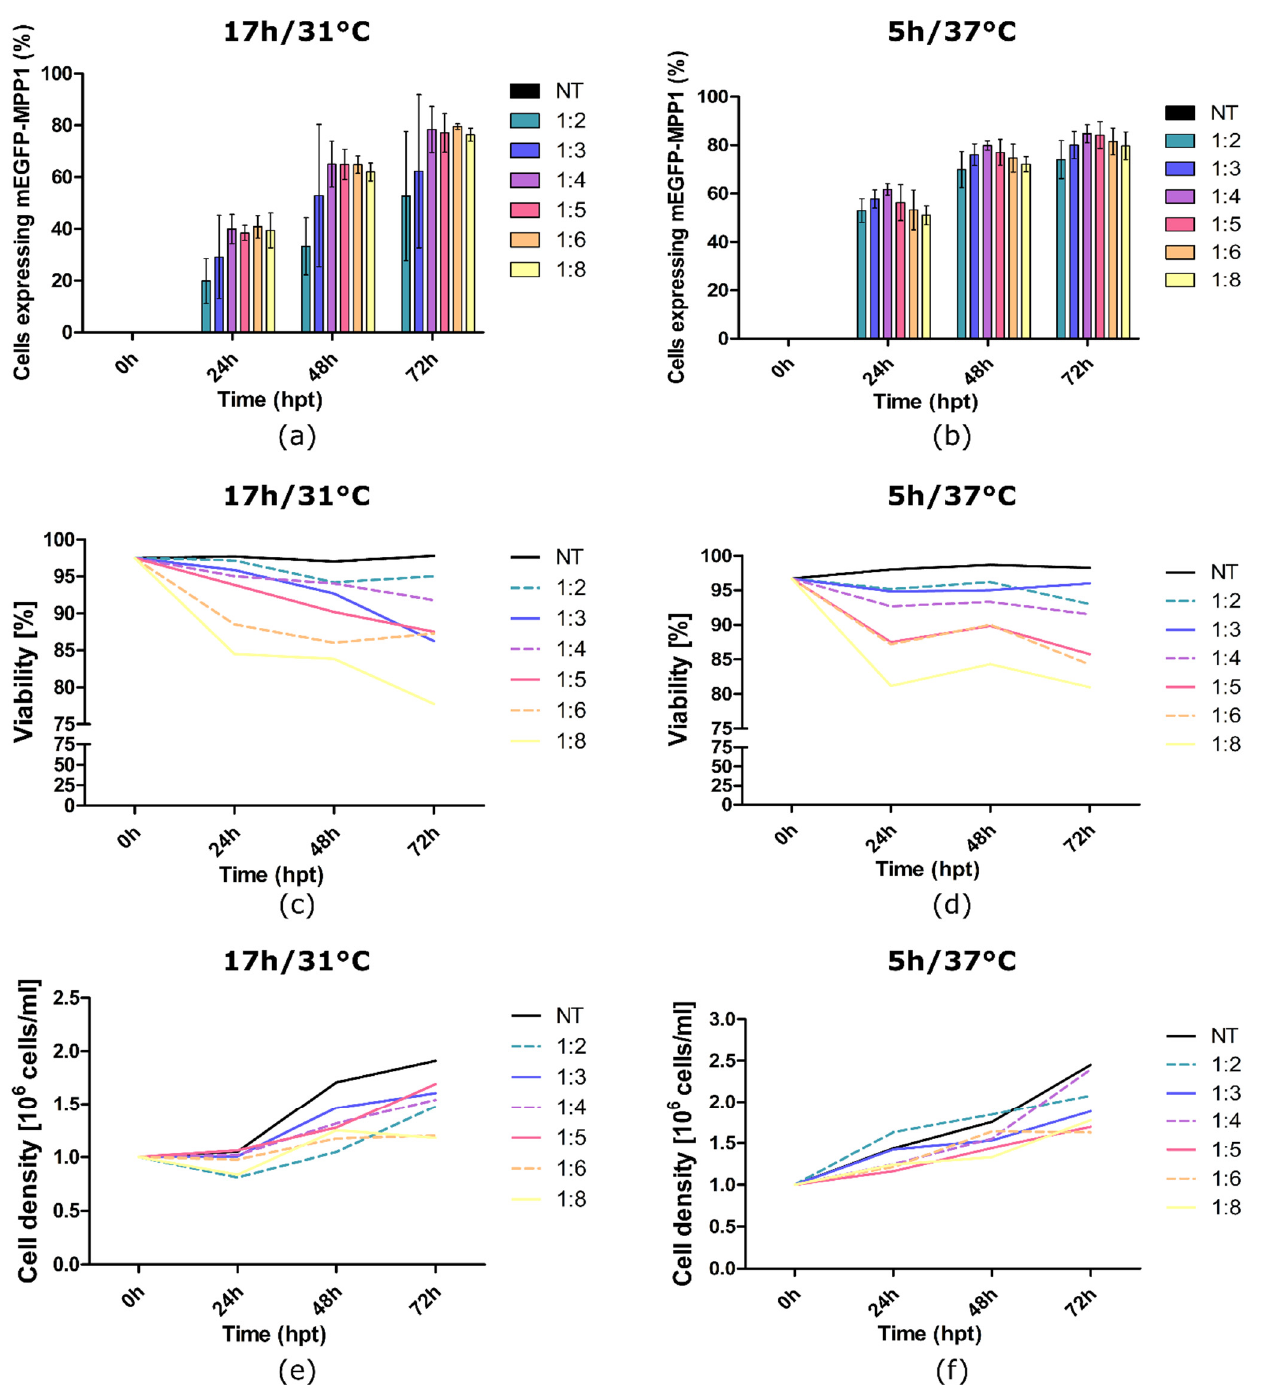
Figure 1. The effect of time, temperature, and DNA/PEI ratio on mEGFP-MPP1 overexpression and HEK-293F cell viability and density. Flow cytometry analysis of the level of mEGFP-MPP1 overexpression after ( a ) 17 h transfection at 31 ◦ C or ( b ) 5 h transfection at 37 ◦ C using different DNA:PEI ratios. Error bars represent SD. Trypan blue-based analysis of the viability of cells transfected for ( c ) 17 h at 31 ◦ C or ( d ) 5 h at 37 ◦ C with different DNA:PEI ratios. The density of cells transfected for ( e ) 17 h at 31 ◦ C or ( f ) 5 h at 37 ◦ C with different DNA:PEI ratios. NT—non-transfected cells/ control; hpt—hours post-transfection. The procedure was performed in